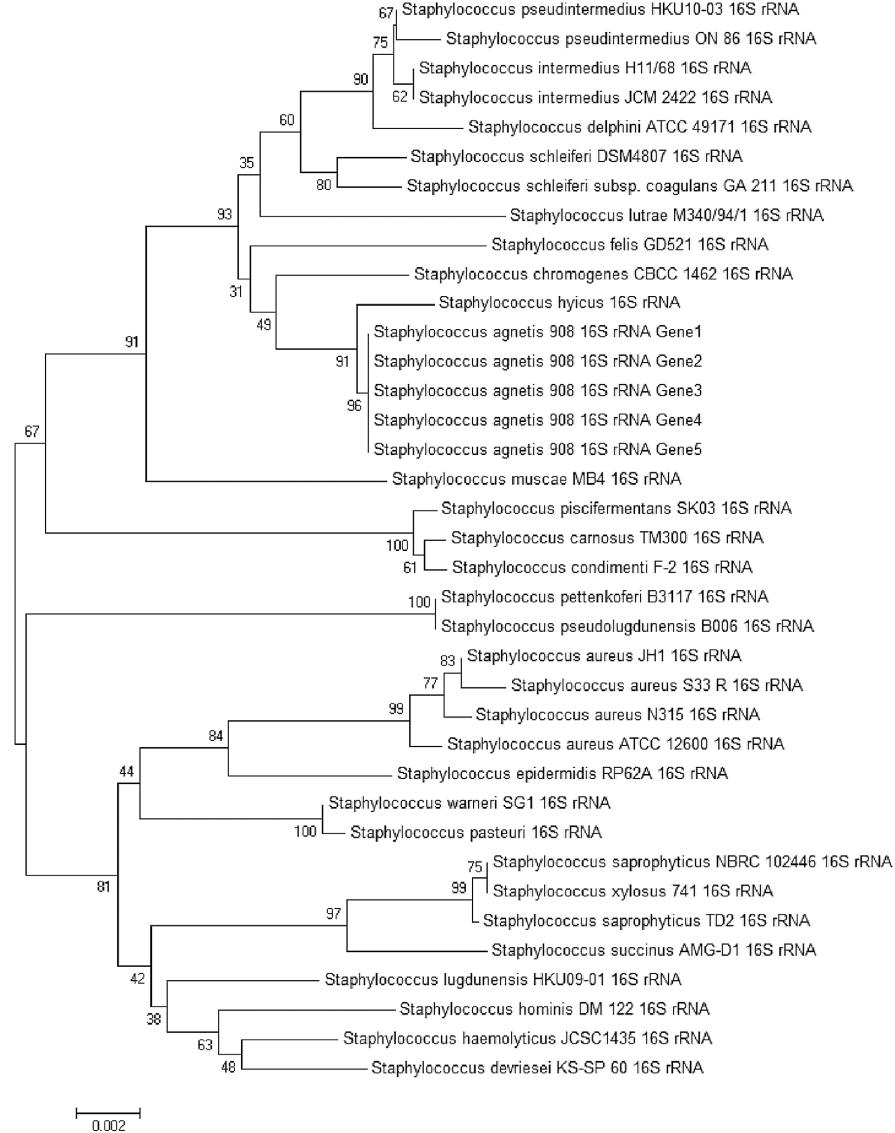
Fig 3. Phylogenetic tree of Staphylococcus species based on 16S rDNA sequences. Full length 16S rDNA sequences for the indicated species and isolates were obtained from NCBI and aligned using ClustalW and used to generate a Neighbor Joining tree (see Materials and